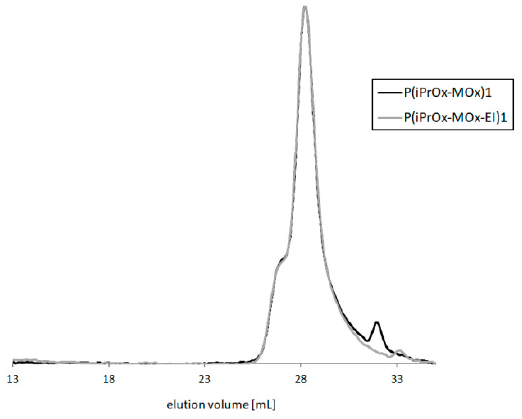
Figure 8. GPC traces of P(iPrOx-MOx)1 and P(iPrOx-MOx-EI)1 (DMF with 5 mmol LiBr as eluent, 1 mL/min, RI signal).